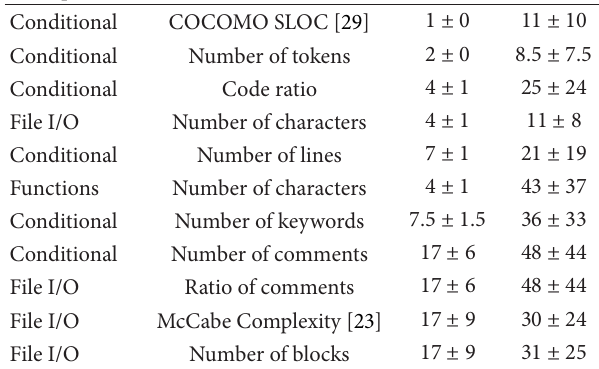
Table 1: Most relevant pairs of software metric/programming concept for the field study mentioned in the text. Observe that the programming concepts in this subset of metrics are “Conditional” and “File I/O,” meaning that the correlation between the scores and “While loop,” “Functions,” “Lists,” or “Standard I/O” is